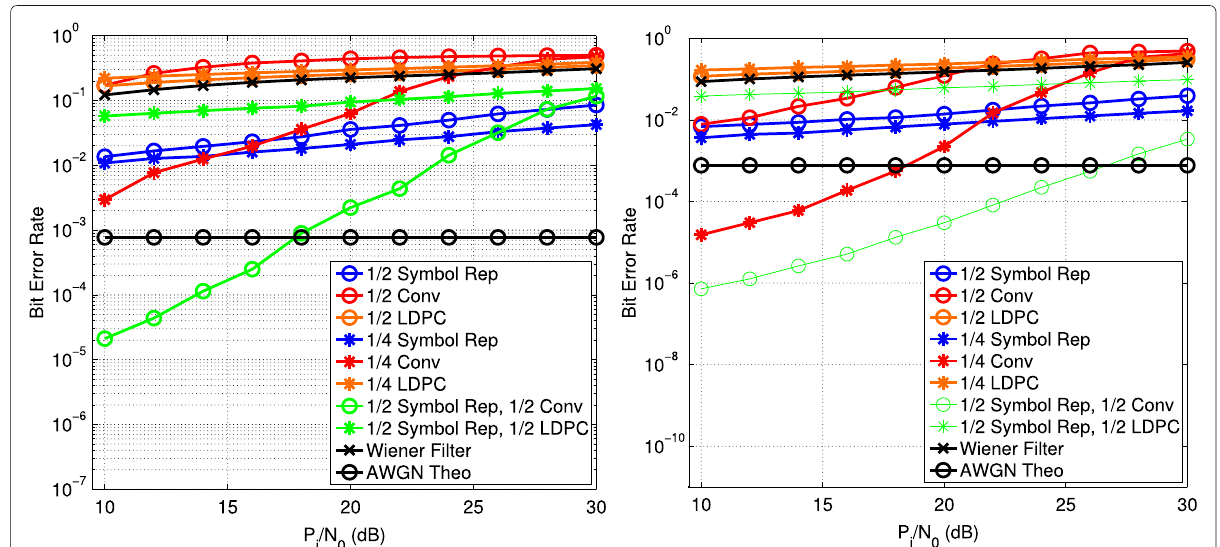
Fig. 11 The BER curves of the symbol repetition and filtering methods as a function of interference to noise power Pi/N0 when Eb/N0 = 7 dB. The methods compared are 1/2 Rate Symbol Repetition PFD (blue circle), 1/4 Rate Symbol Repetition PFD (blue star), 1/2 Rate Convolutional Code (red circle), 1/4 Rate Convolutional Code (red star), 1/2 Rate LDPC (orange circle), 1/4 Rate LDPC (orange star), combined 1/2 Rate Symbol Repetition and 1/2 Rate Convolutional Code (green circle), combined 1/2 Rate Symbol Repetition and 1/2 Rate LDPC (green star), Wiener Filter (black x). The AWGN Theoretical is plotted with a black circle. a Bandwidth overlap of 1/2. b Bandwidth overlap of 1/4